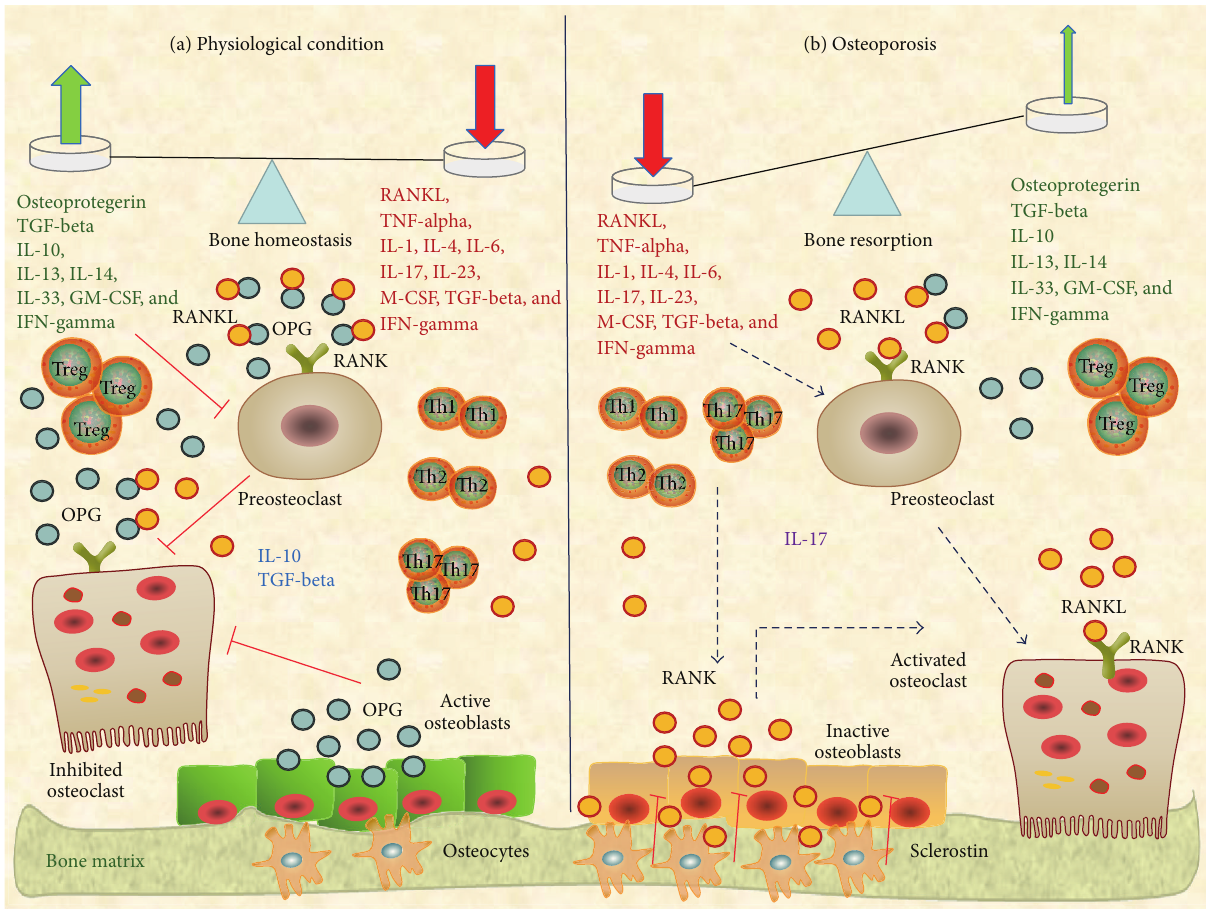
Figure 2: Osteoclastogenic pathways in “bone immunological niche.” At bone tissue level, on one hand, there are the proinflammatory Th1, Th2, and Th17 cells with related proosteoclastogenic cytokines (RANKL, TNF-alpha, IL-1, IL-4, IL-6, IL-17, IL-23, M-CSF, TGF-beta, and IFN-gamma) and other immune cells such as proinflammatory macrophages; on the other hand, there are the anti-inflammatory Tregs with related antiosteoclastogenic cytokines (OPG, TGF-beta, IL-10, IL-13, IL-14, IL-33, GM-CSF, and IFN-gamma) and other immune cells with regulatoryfunctions,suchasosteomacs.Thebonemicroenvironmentfunctionsasadynamicmodelinwhichacontinuousbalancingbetween proosteoclastogenic and antiosteoclastogenic mediators is performed. (a) In physiological condition anti- and proosteoclastogenic factors are in equilibrium and bone homeostasis is conserved. (b) In osteoporosis condition, proosteoclastogenic factors prevail and bone resorption and remodeling develop. OPG: osteoprotegerin, GM-CSF: granulocyte-macrophage colony stimulating factor, and M-CSF: macrophage colony stimulating